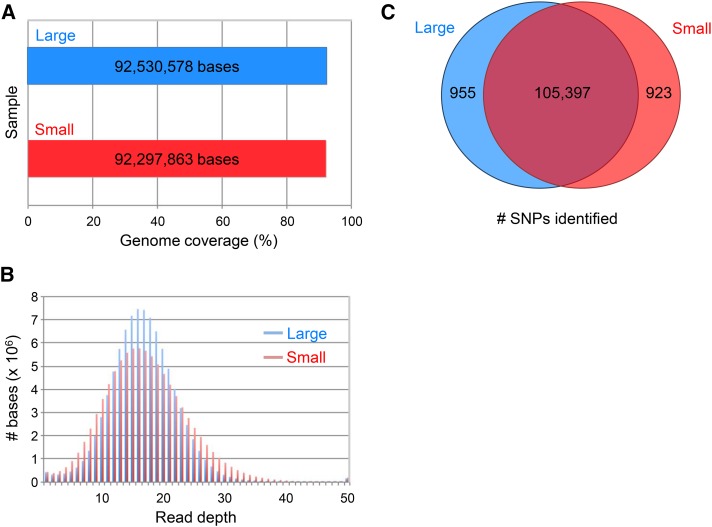
Coverage for large vs. small-input Hawaiian samples. A. Number of bases in the reference genome covered by at least three uniquely mapped reads. B. Read depth distribution for the large (blue) and small (red) input samples. C. Venn diagram indicating the number of Hawaiian SNPs identified in each sample.